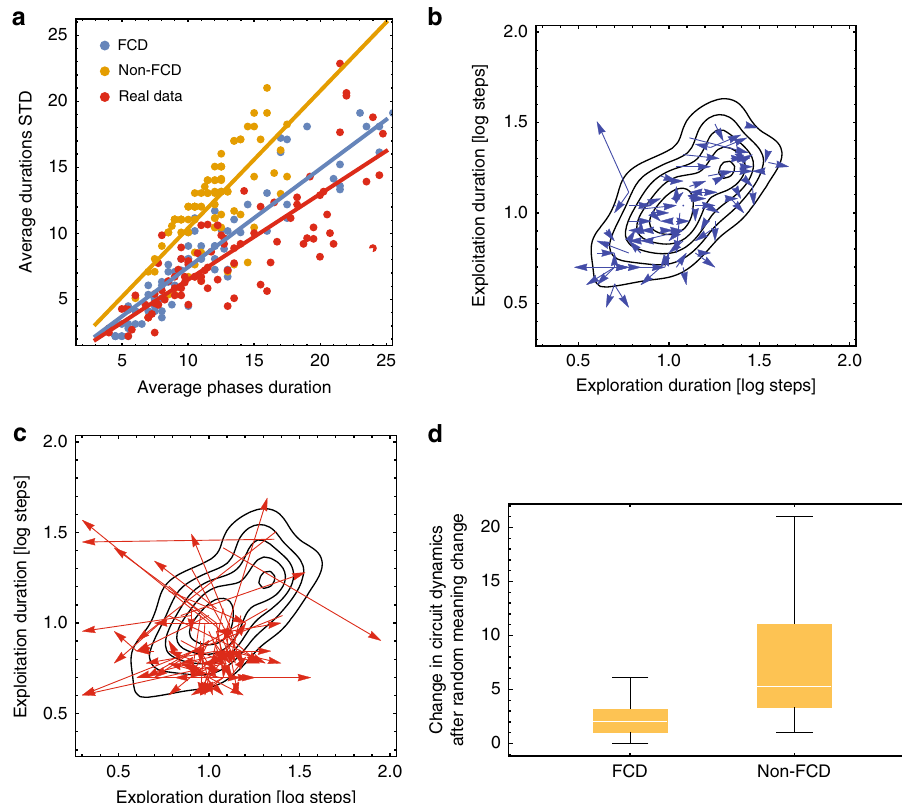
Fig. 6 FCD dynamics are robust to variations in meaning perception. a The variance of the FCD circuit (blue) is signi fi cantly lower than that of the non-FCD circuit (orange), and aligns with the behavioral data (red) (FCD (blue): slope = 0.74, 95% CI = [0.71, 0.77], non-FCD (Orange): slope = 1.04, 95% CI = [1, 1.08], Behavioral data (red): slope = 0.65, 95% CI = [0.61, 0.69]). b , c FCD circuit dynamics are robust to large variations in meaning dimension ’ s average meaning score, while the non-FCD circuit dynamics change drastically. Arrows indicate the change in dynamics upon a random scaling of meaning dimensions for FCD response (blue arrows, b ), and non-FCD response (red arrows, c ). d Average arrow length in the case of b and c . FCD, median arrow norm = 2, 95% CI = [1.4, 2.2], non-FCD, median arrow norm = 5.2, 95% CI = [4.1, 6.3], Mann – Whitney Test, U = 1207, p < 10 − 5 , effect size = 0.64. Center line in each box is the median value, box bounds are 25%, 75% quantiles, and whiskers show max and min values of